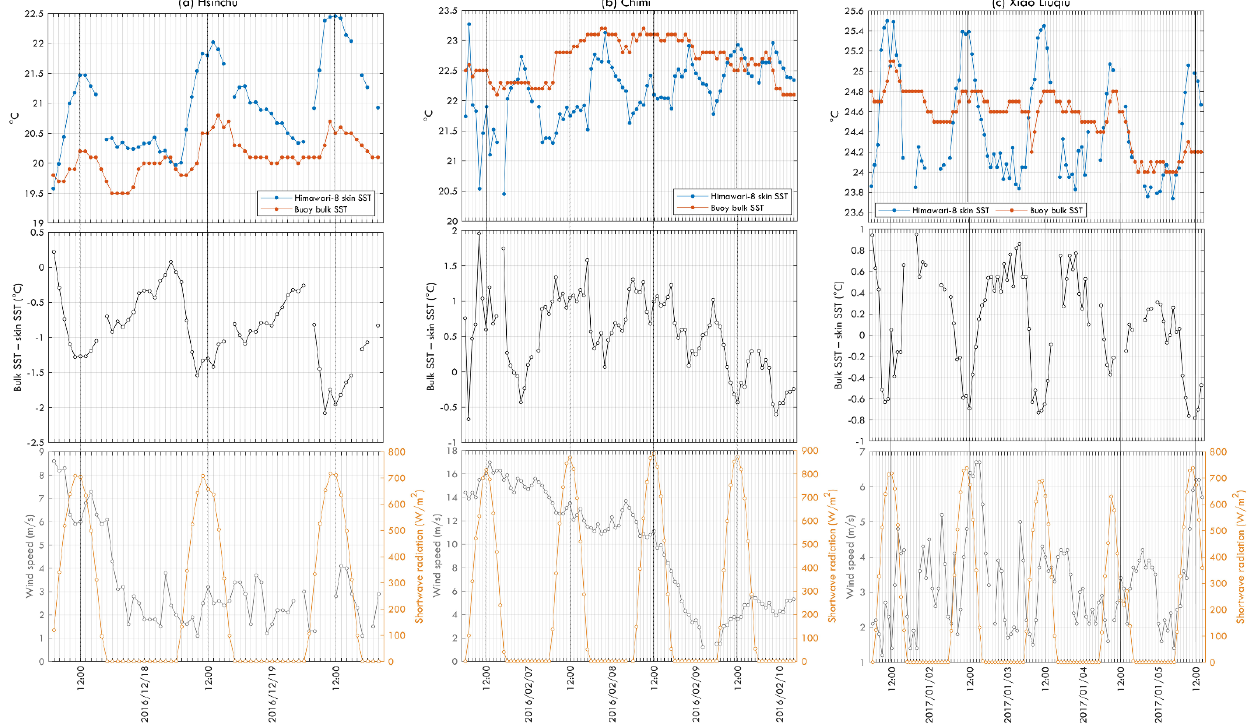
Figure 8. Time series variations of bulk and skin SST in (a) Hsinchu, (b) Chimi, and (c) Xiao Liuqiu, and their correspond- ing solar shortwave radiation and wind